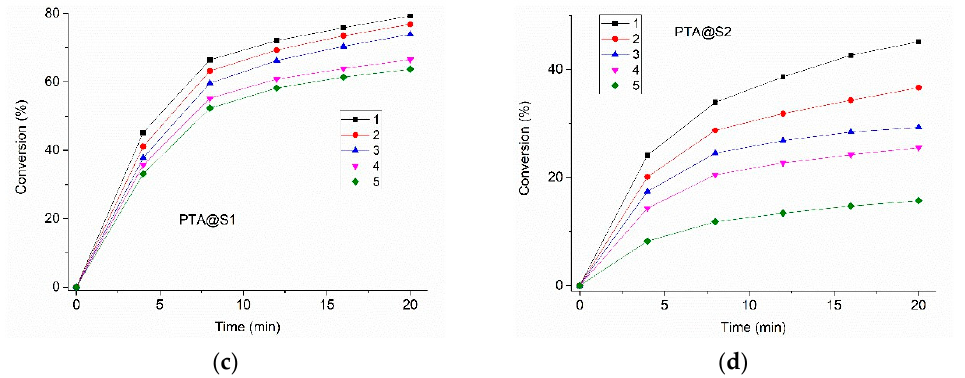
Figure 4. ( a ) Time-variable conversion of the ring opening of styrene oxide with methanol over S1, S2,